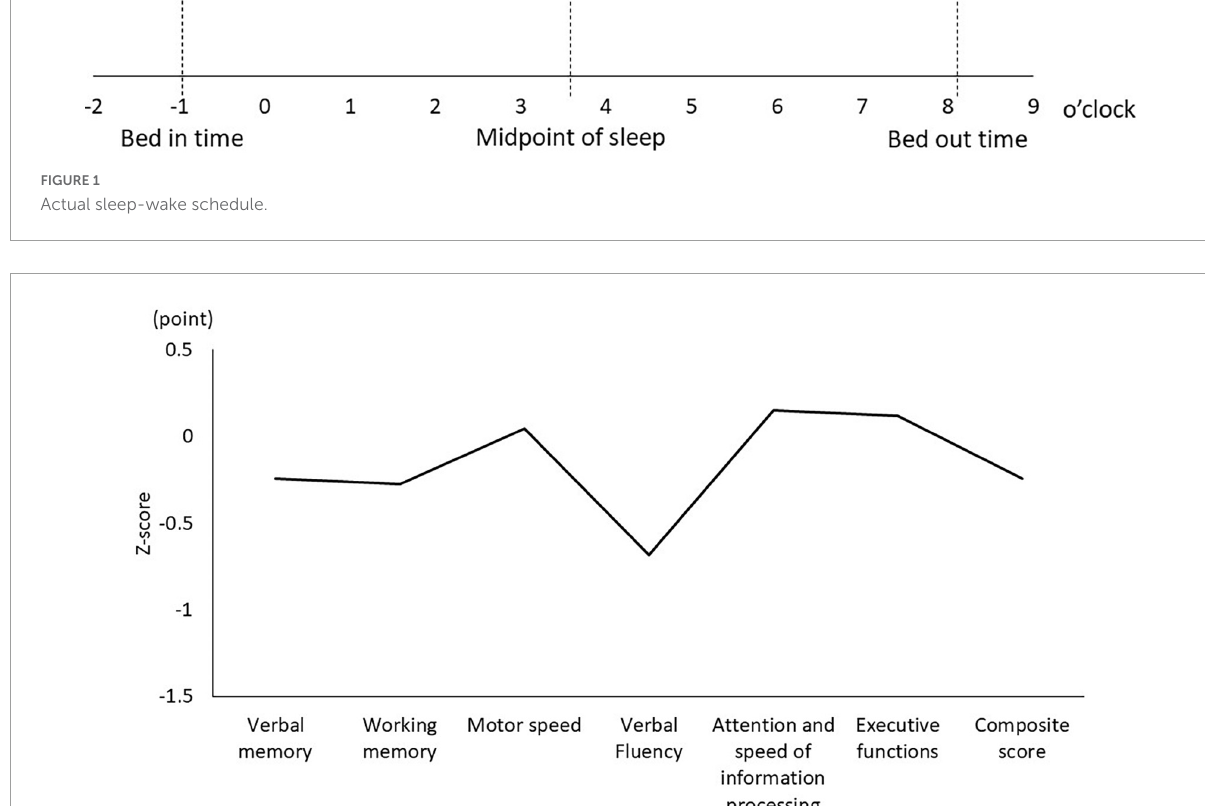
FIGURE2 Composite score and each domain of the BACS-J. BACS-J: Japanese version of the Brief Assessment of Cognition in